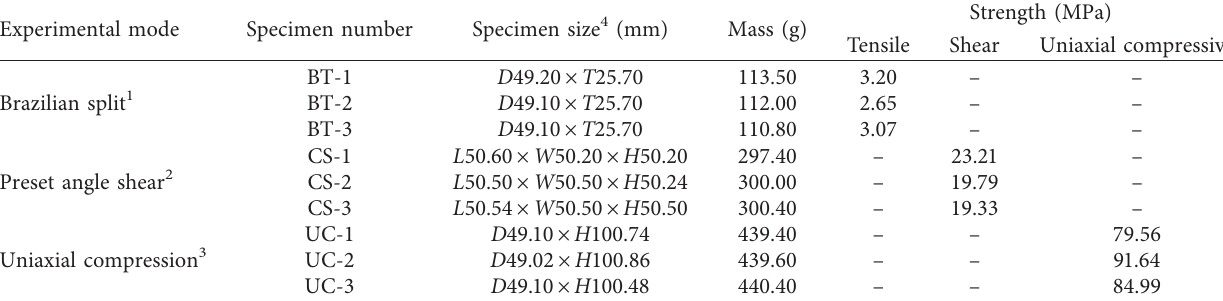
Table 1: Basic physical and mechanical parameters of sandstone.